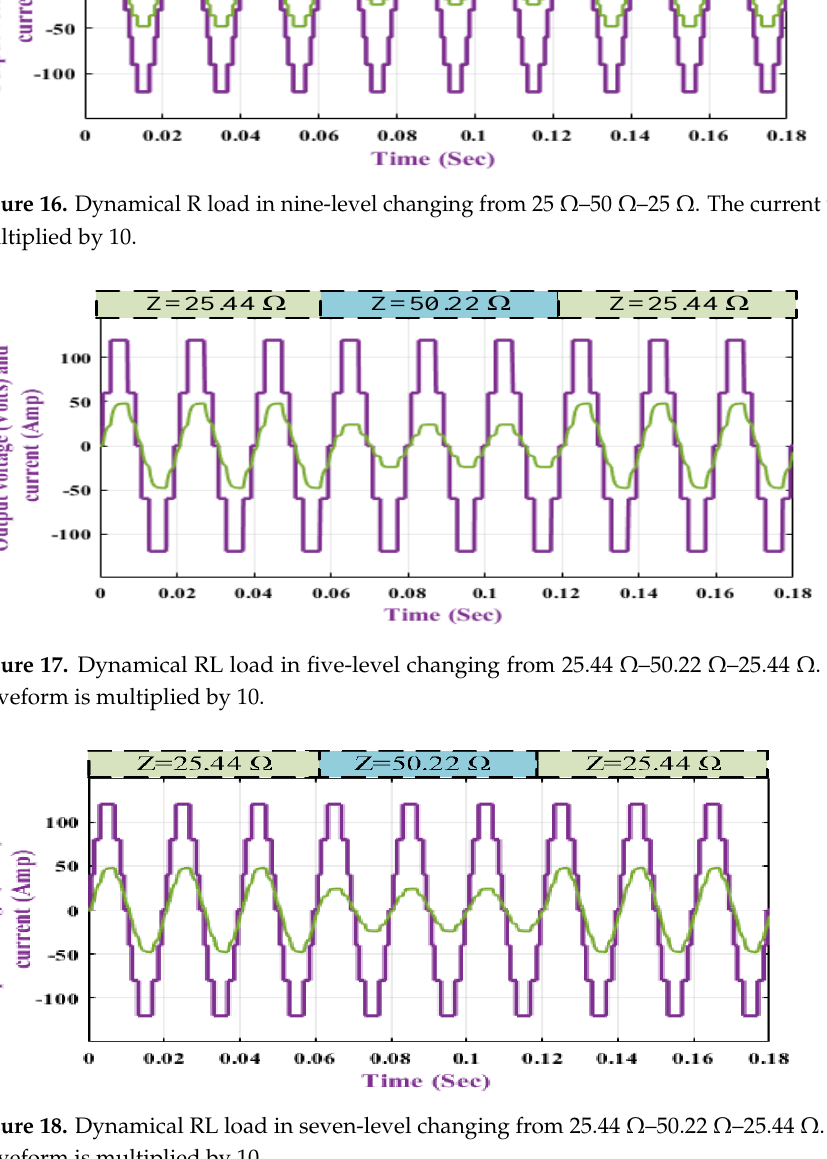
Figure 18. Dynamical RL load in seven-level changing from 25.44 Ω– 50.22 Ω– 25.44 Ω. The current waveform is multiplied by 10.